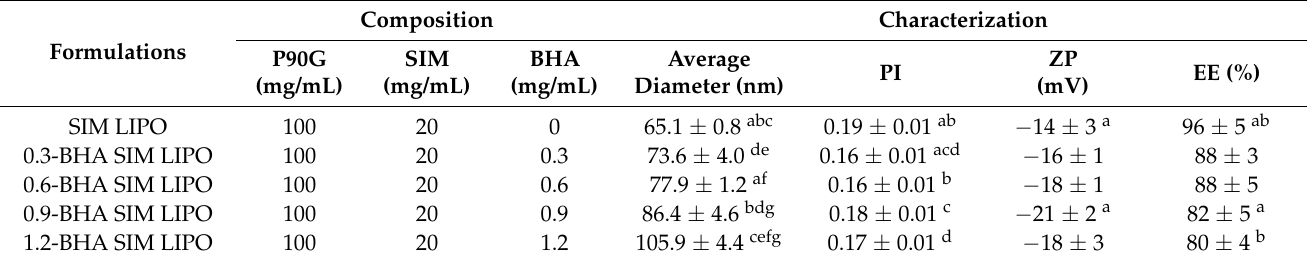
Table 1. Composition and characteristics of liposomes in terms of average diameter (nm), polydisper- sity index (PI), zeta potential (ZP, mV), and encapsulation efficiency (EE, %). Pairs of values of the same parameter that are significantly different are marked with the same small